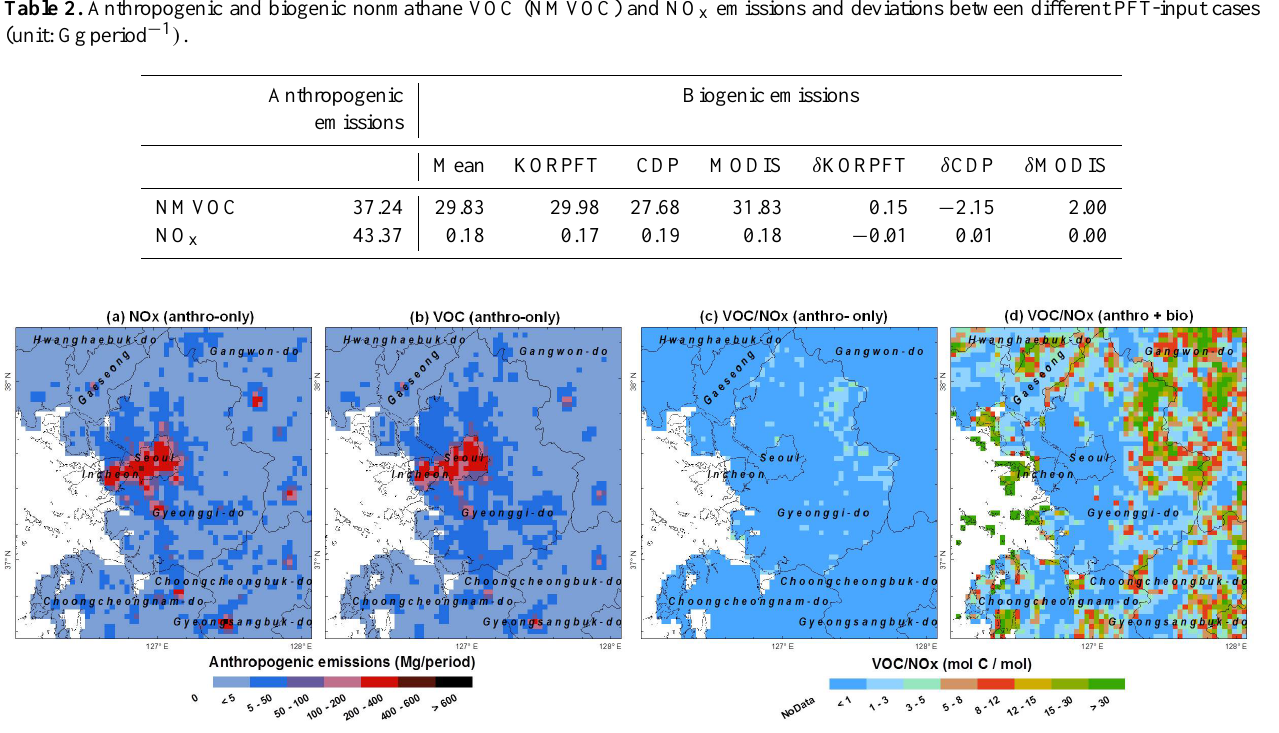
Figure 2. Geospatial distributions of estimated anthropogenic emissions for NO x and VOCs and their ratios for the study period (May–June 2008). The VOC/NO x ratio for the “anthro-only” case includes only the anthropogenic VOCs and NO x emissions; the “anthro + bio” case includes both the anthropogenic and biogenic VOCs and NO x